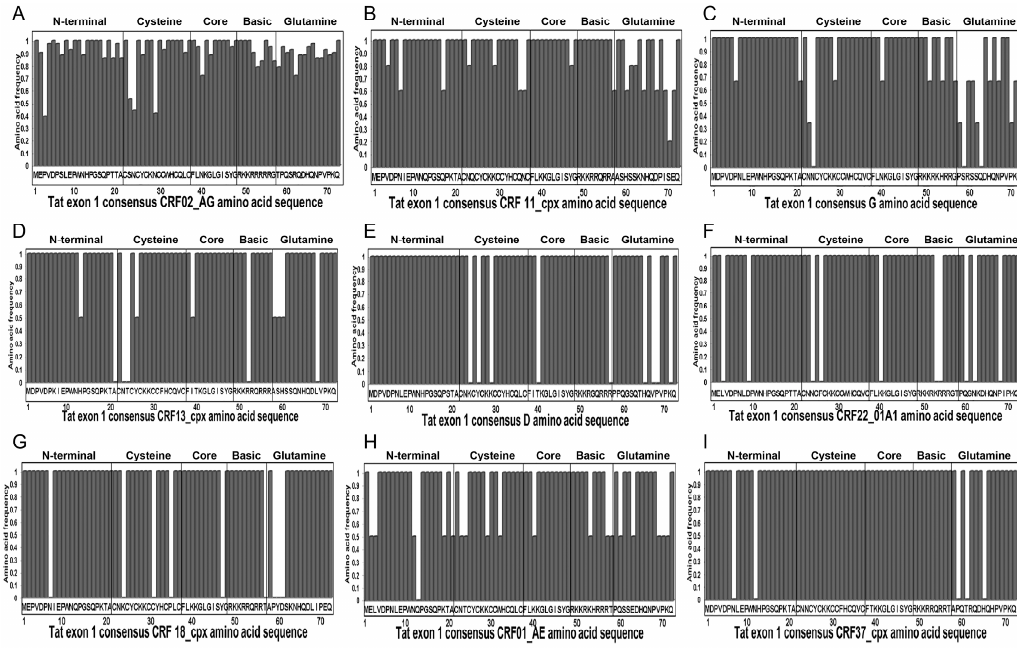
Figure 3. Tat exon-1 amino acid (aa) sequences of Cameroon clinical isolates. Data show Cameroon HIV-1 strains Tat exon-1 aa signature patterns for: HIV-1 CRF02_AG ( A ); CRF11_cpx ( B ); subtype G ( C ); CRF13_cpx ( D ); subtype D ( E ); CRF22_01A1 ( F ); CRF18_cpx ( G ); CRF01_AE ( H ); and CRF37_cpx ( I );